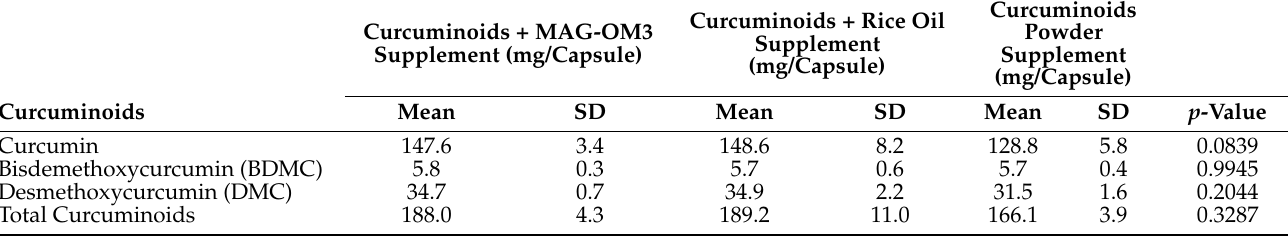
Table 1. Curcuminoids content in the supplements 1 .